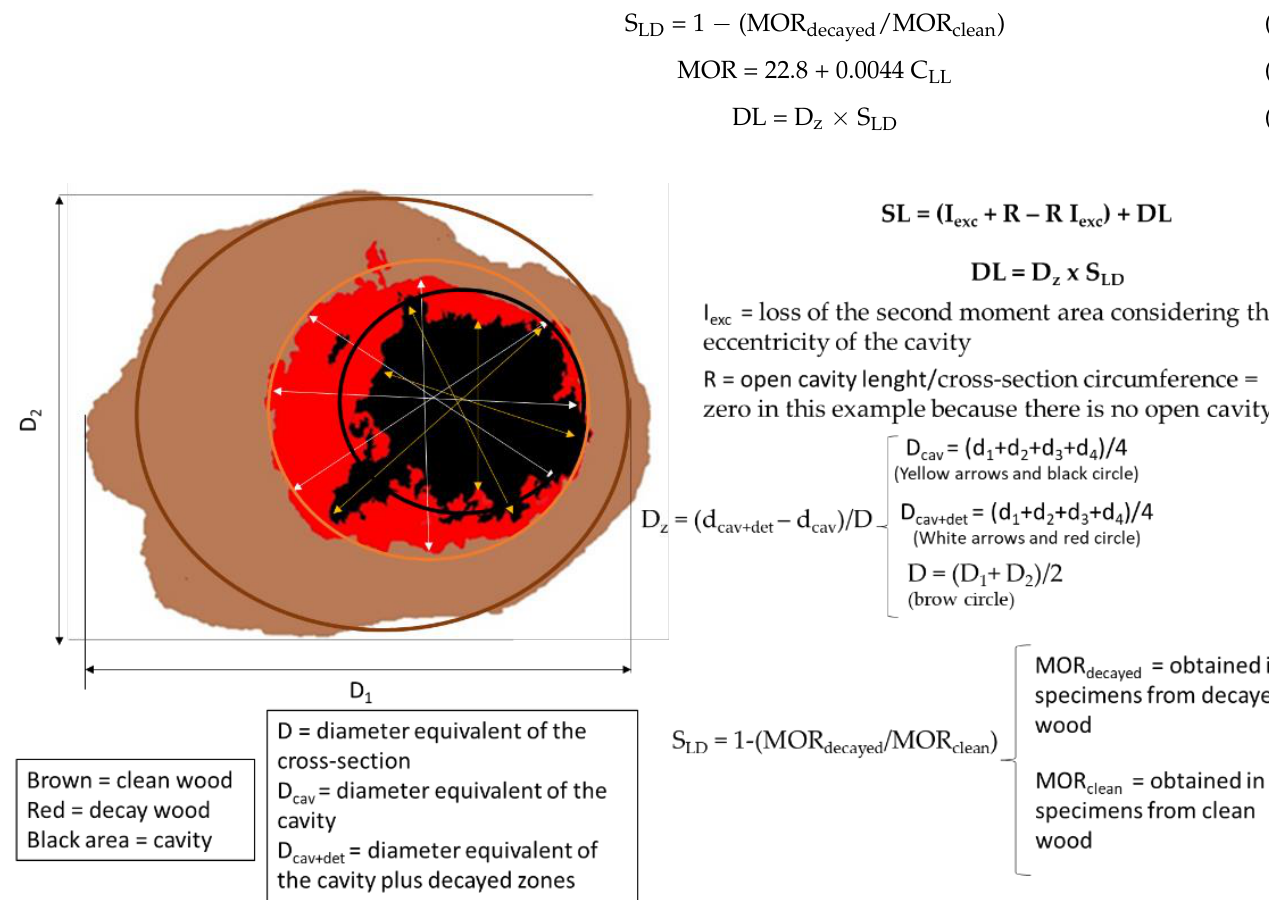
Figure 8. Example of the steps used to calculate Equation (10).